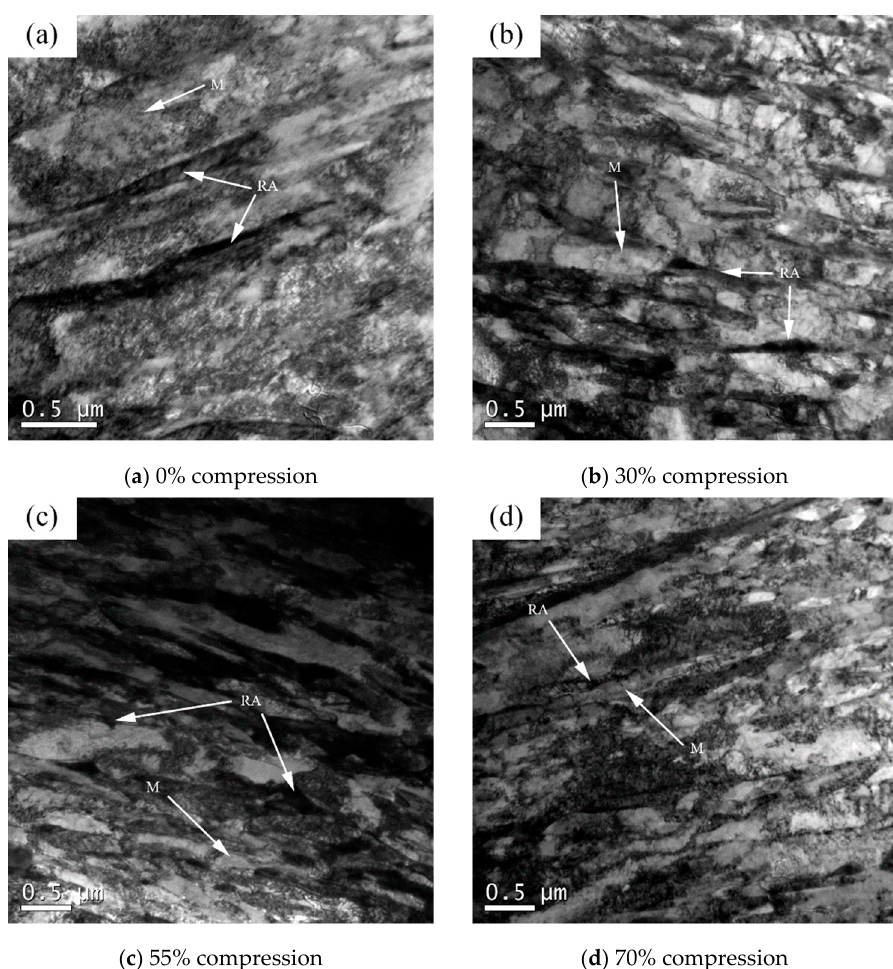
Figure 5. Transmission electron microscopy (TEM) micrographs after different degrees of deformation.